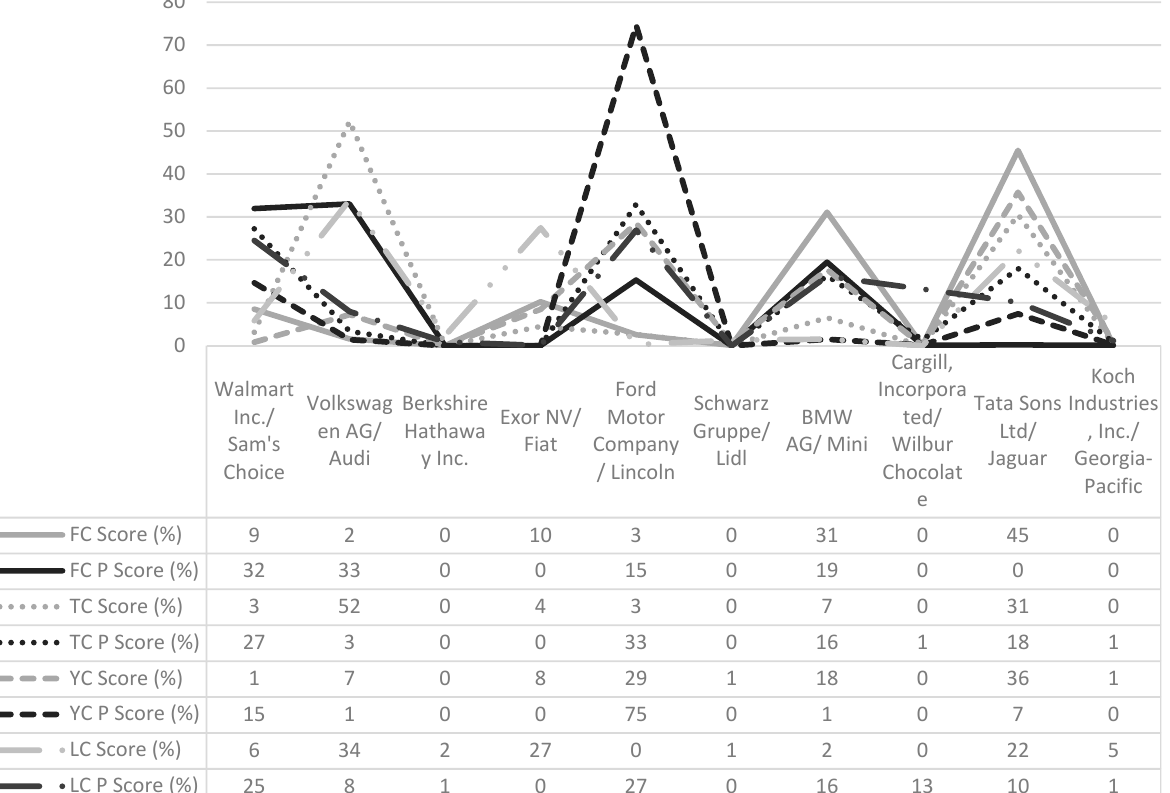
Figure 1. Comparison of the parent companies against their brands: ( a ) results of the Advanced sentiment analysis (ASA); ( b ) results of the total level of online reputation (TOR).